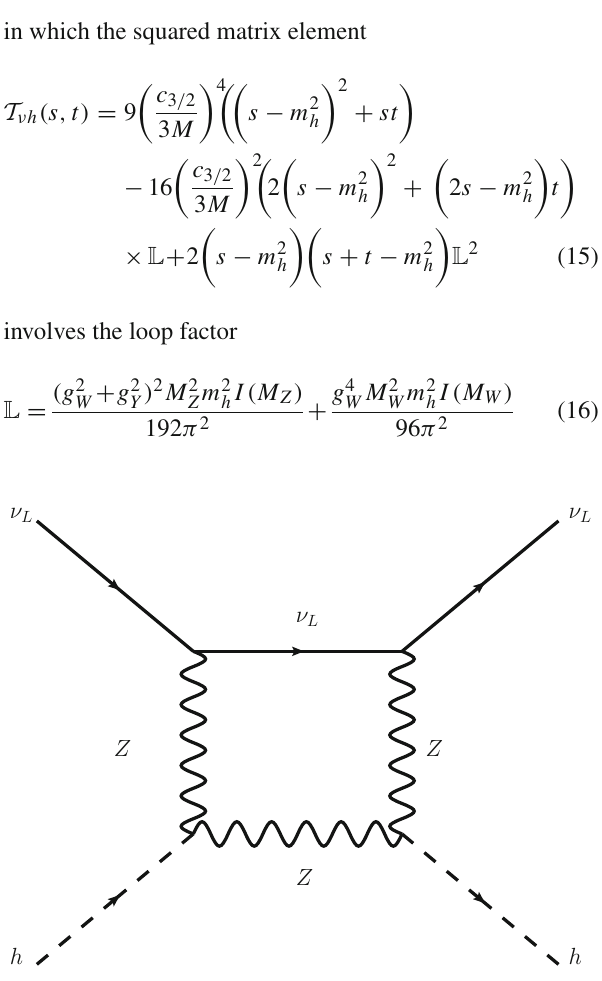
Fig. 2 The ν – Z box mediating the ν L h → ν L h scattering in the SM. The e – W box is not shown